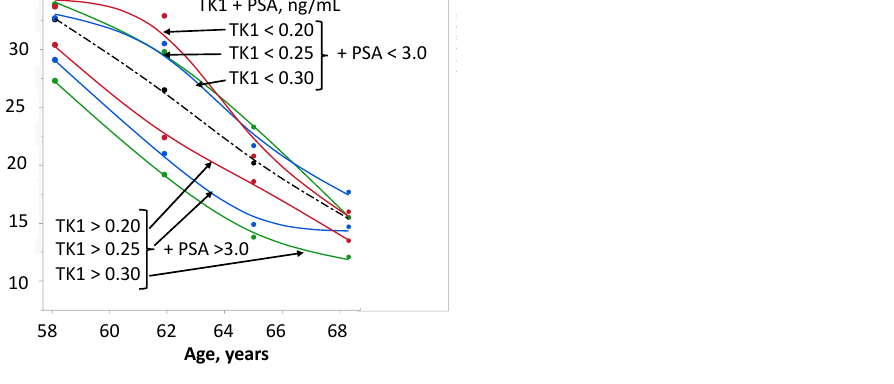
Figure 8. Survival probability of 175 men with prostate cancer stratified by age and different cut-off values of TK1 concentration in combination with PSA below and above 3.0 ng/ml.